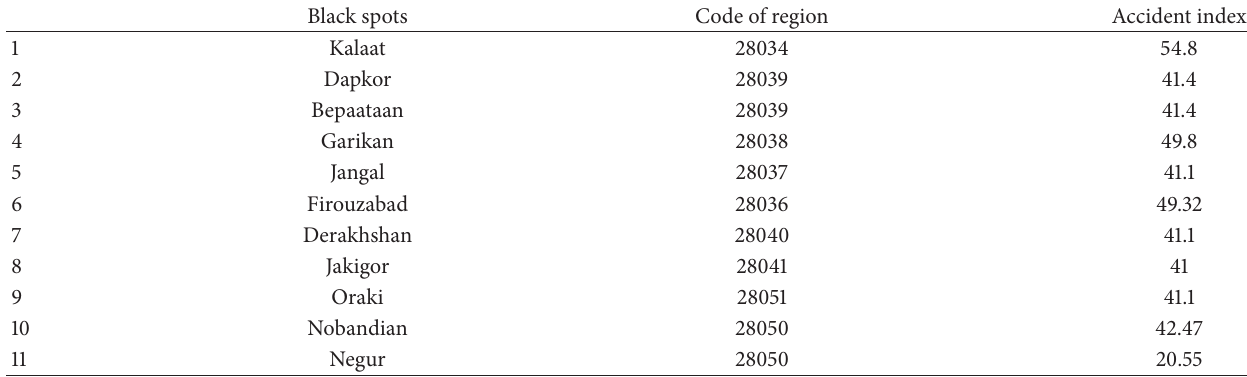
Table 13: Identification of black spots using accident information reported by traffic police in